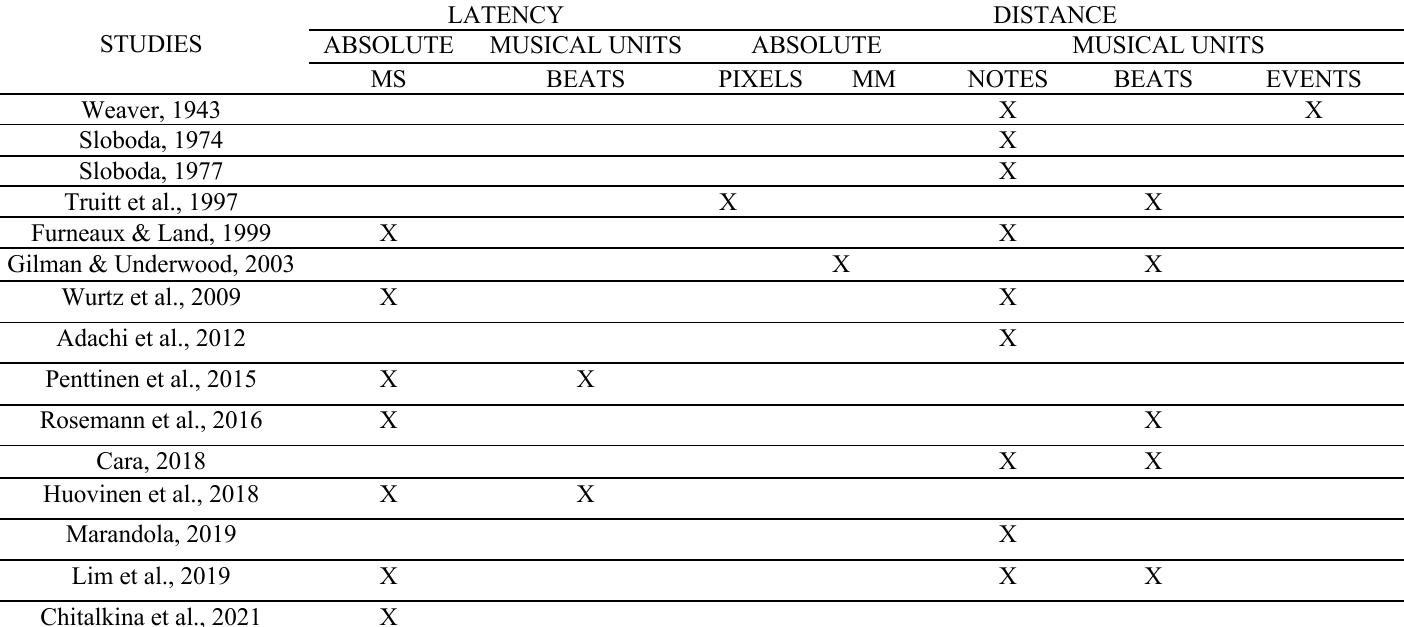
Table 2. Eye-hand span measurement method by